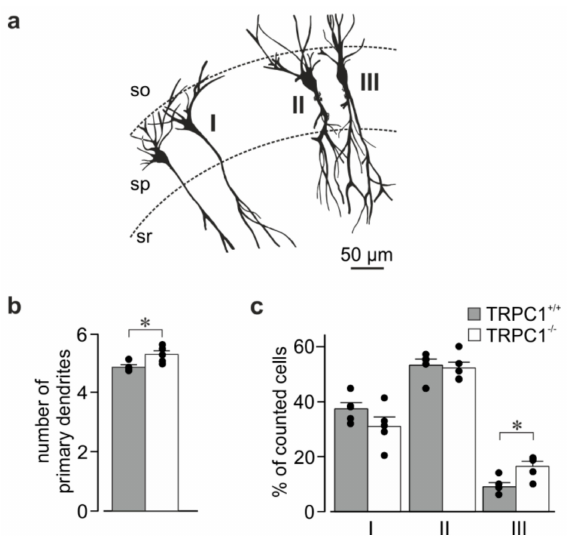
Figure 5. Major dendrite morphology in CA1 neurons from TRPC1 +/+ and TRPC1 − / − mice. ( a ) Tracings of four Golgi-stained neurons in one slice showing two neurons of category I (left), and single neurons of categories II and III (right) into which neurons from TRPC1 +/+ and TRPC1 − / − mice were classified. SO: stratum oriens , SP: stratum pyramidale , SM: stratum moleculare . ( b ) The average number of primary dendrites (sum of apical and basal dendrites) in CA1 neurons from TRPC1 +/+ and TRPC1 − / − mice. ( c ) Percentage of neurons showing the branching patterns I, II and III (see (a)) in TRPC1 +/+ and TRPC1 − / − mice. The data are means ± SEM from five mice of each genotype and 112–248 neurons per mouse, and * indicates p < 0.05, Student’s t test). Dots indicate the values from individual